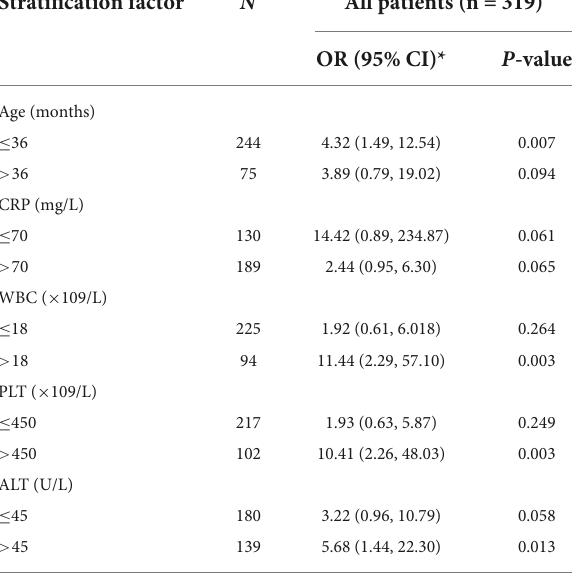
TABLE 3 Stratified analysis of the effects of ALB levels on CALs progression among Kawasaki disease